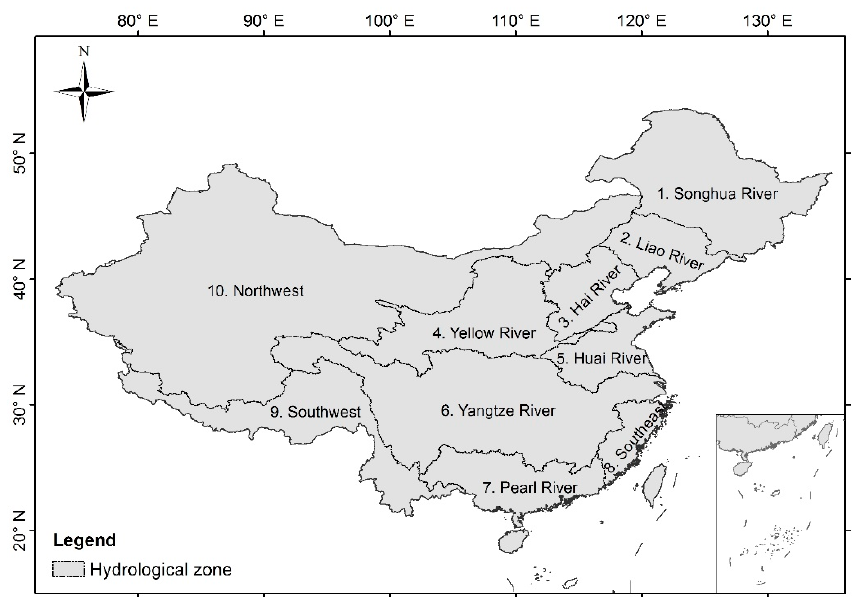
Figure 1. The 10 major hydrological zones of China denoted by a unique number: 1. Songhua River; 2. Liao River; 3. Hai River; 4. Yellow River; 5. Huai River; 6. Yangtze River; 7. Pearl River; 8. Southeast region; 9. Southwest region; and 10. Northwest region.